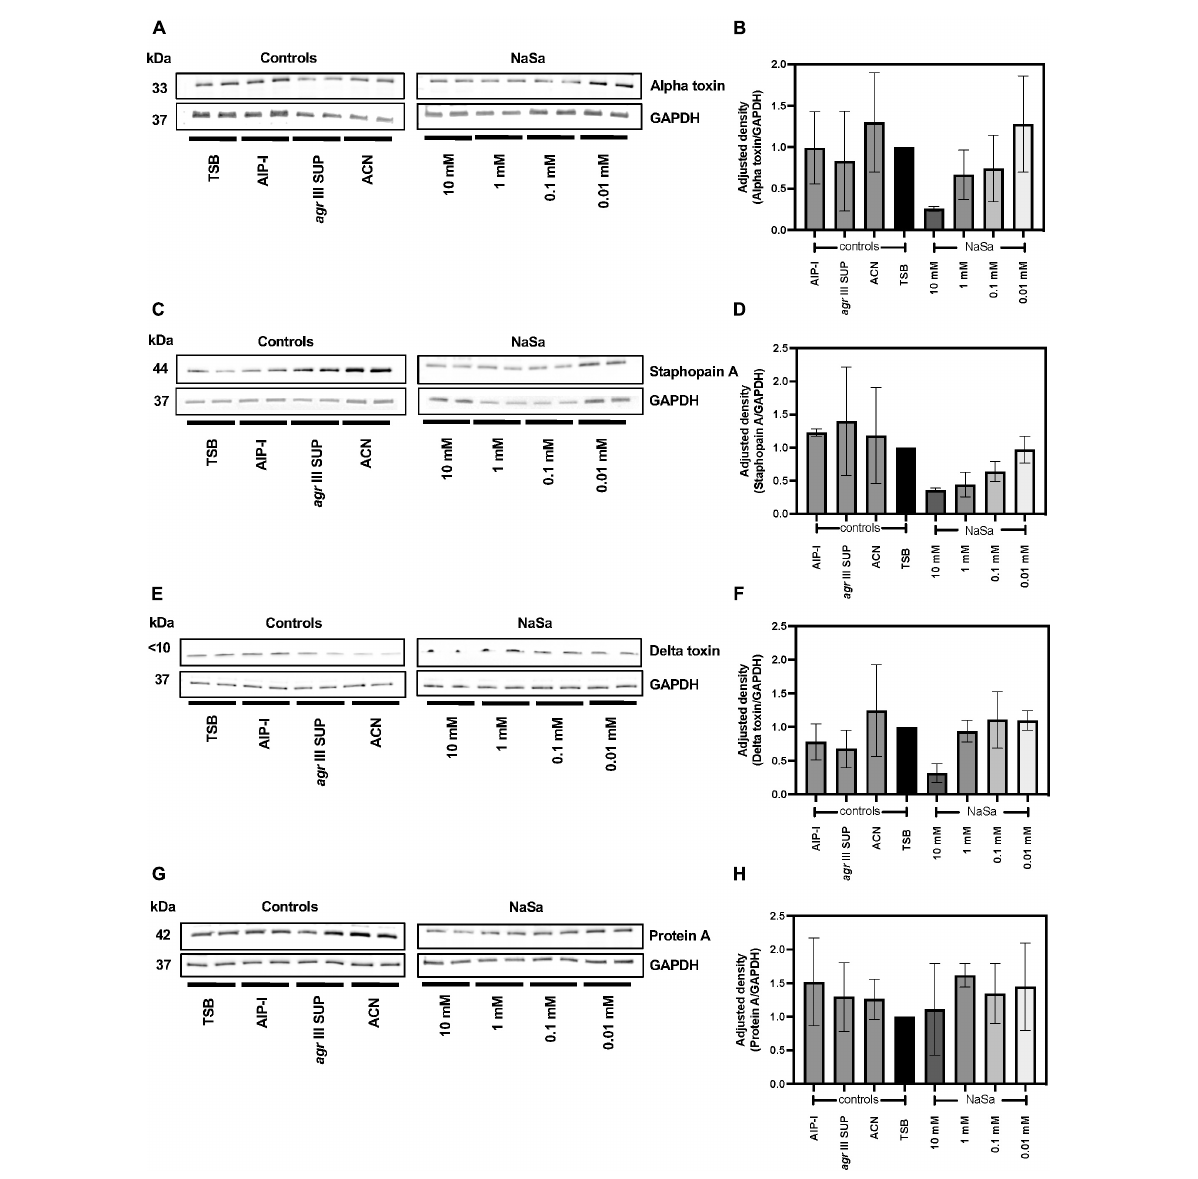
FIGURE3 NaSa decreases production of virulence factors in S. aureus . The production of alpha toxin (A,B) , staphopain A (C,D) , delta toxin (E,F) , and protein A (G,H) was analyzed using western blot and densitometry analysis. GAPDH was used as a loading control. The displayed images are representative of three independent experiments. Each bar represents the mean from three independent experiments ± SD . 10 mM NaSa showed a decreasing trend in the secretion of alpha toxin, staphopain and delta toxin compared to TSB (Tryptic Soy Broth) as media using one-way ANOVA Dunnett’s test. AIP-I, Autoinducing Peptide-I; SUP, supernatant; ACN, acetonitrile, used as AIP-I diluent